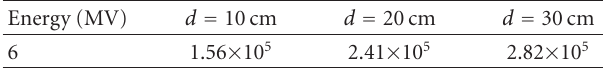
Table 3: The total number of Cerenkov photons (that are generated in the detector and reach the AMFPI) per LINAC pulse ( ∼ 0.026cGy dose-to-water at the isocentre ) for a 6 MV beam and various detector thicknesses. Statistical uncertainty for each value is ∼ 0.8%.